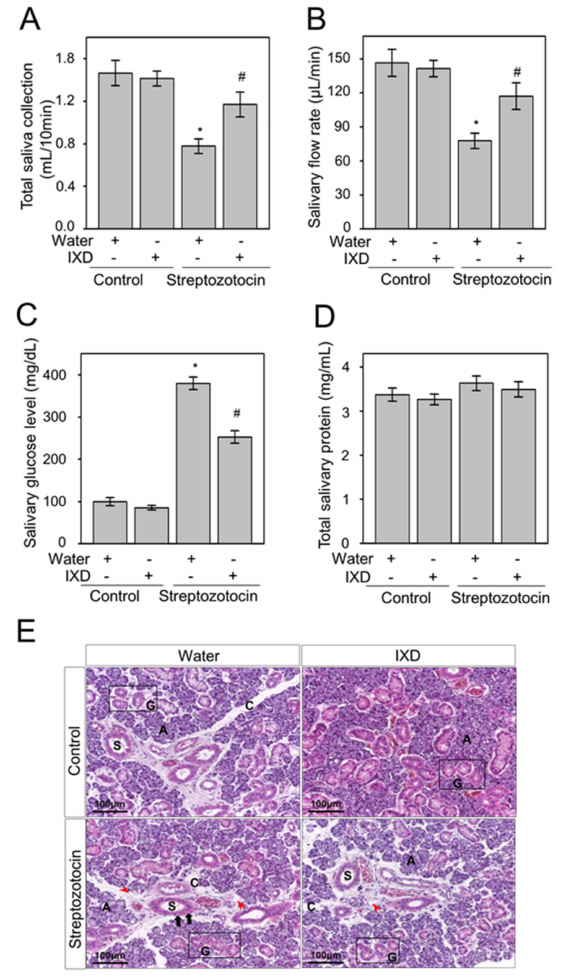
Figure 3. The effects of the IXD extract on salivary parameters. ( A ) Total salivary volume (mL) collected at 10 min after pilocarpine injection; ( B ) the total salivary flow rate was measured in µ L/min; ( C ) measurement of glucose concentration in saliva; ( D ) measurement of total protein concentration in saliva (mg/mL). Values are represented as mean ± SEM ( n = 10 per group, p < 0.05). * indicates significant differences compared to vehicle-treated control rats and # indicates significant differences compared to STZ-induced diabetic rats; ( E ) haematoxylin and eosin staining showing the morphological appearance of the submandibular glands of control and diabetic rats. Red arrowheads show variable degrees of vacuolization of the connective tissue stroma. Black arrows show slightly dilated and pyknotic nuclei in striated ducts. Characters showing in pictures such as A, C, S and G denotes for acinar cells, connective tissue stroma, striated ducts and granular convoluted tubules respectively. Magnification: 20 × ; Scale bar: 100 µ